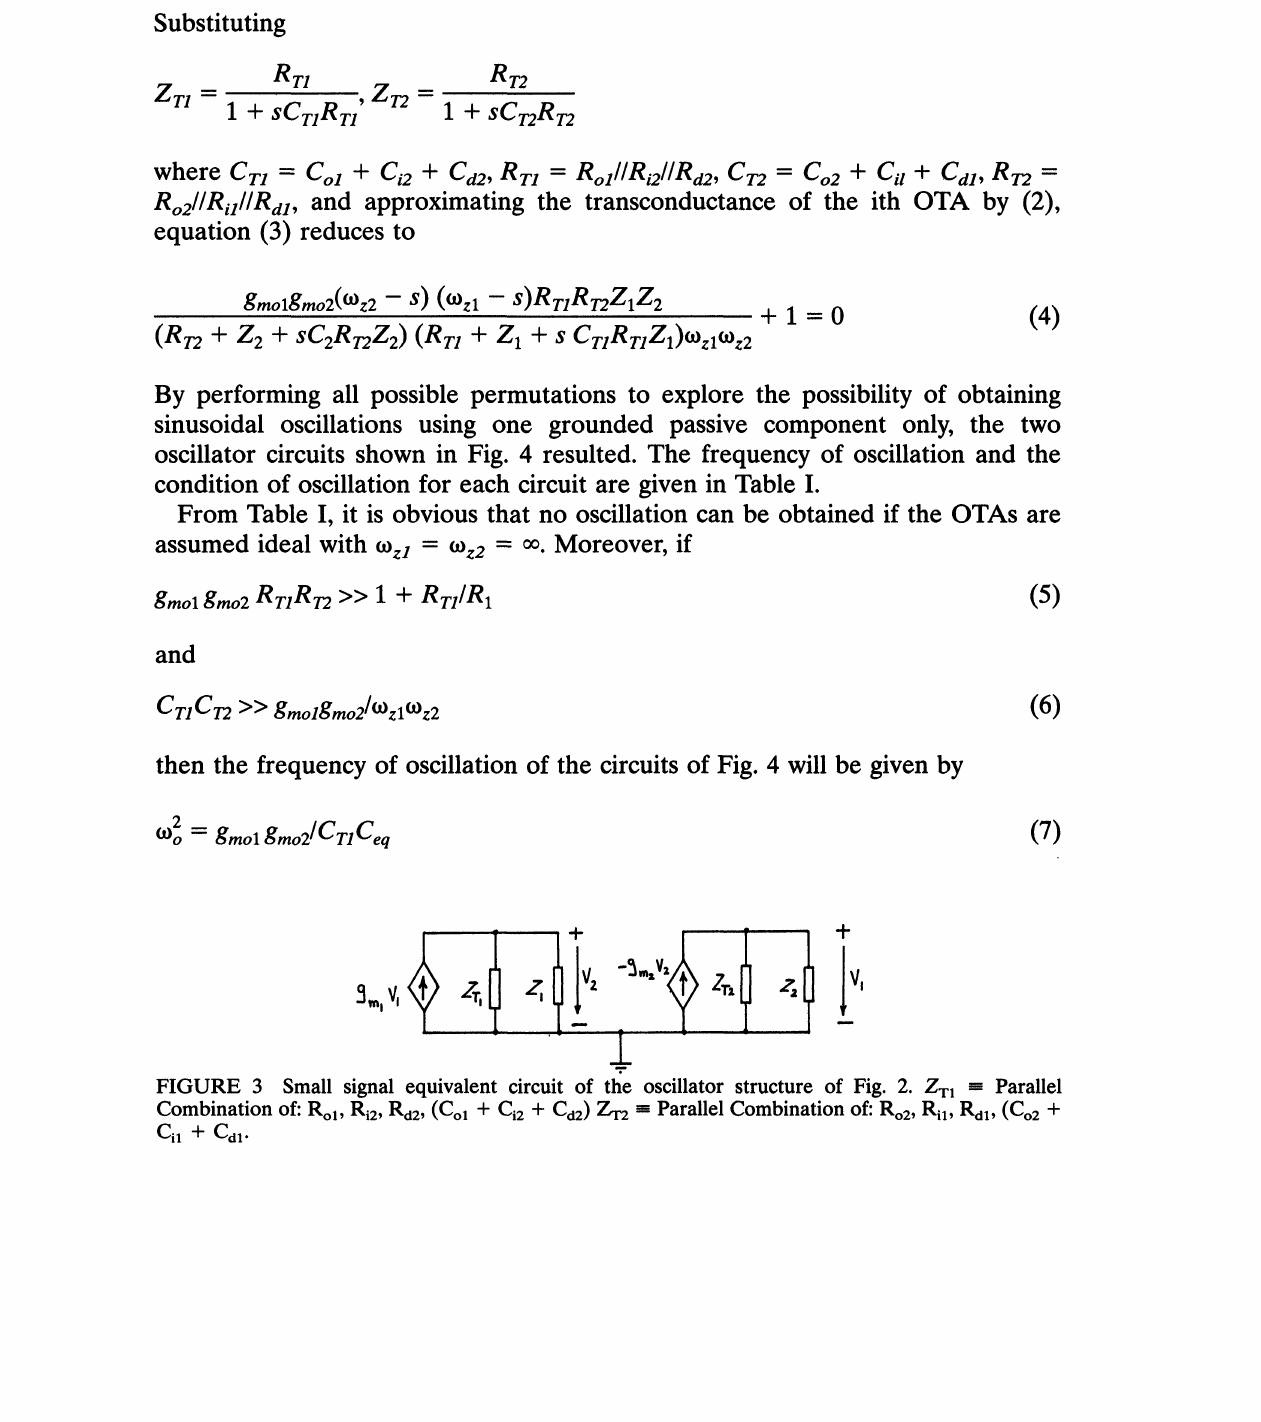
FIGURE 3 Small signal equivalent circuit of the oscillator structure of Fig. 2. ZT, Parallel Combination of: Ro,, Ri2, Ra2, (Co, + Ci2 + Ca2) Z Parallel Combination of: RoE, Ri,, Ra,, (Co2